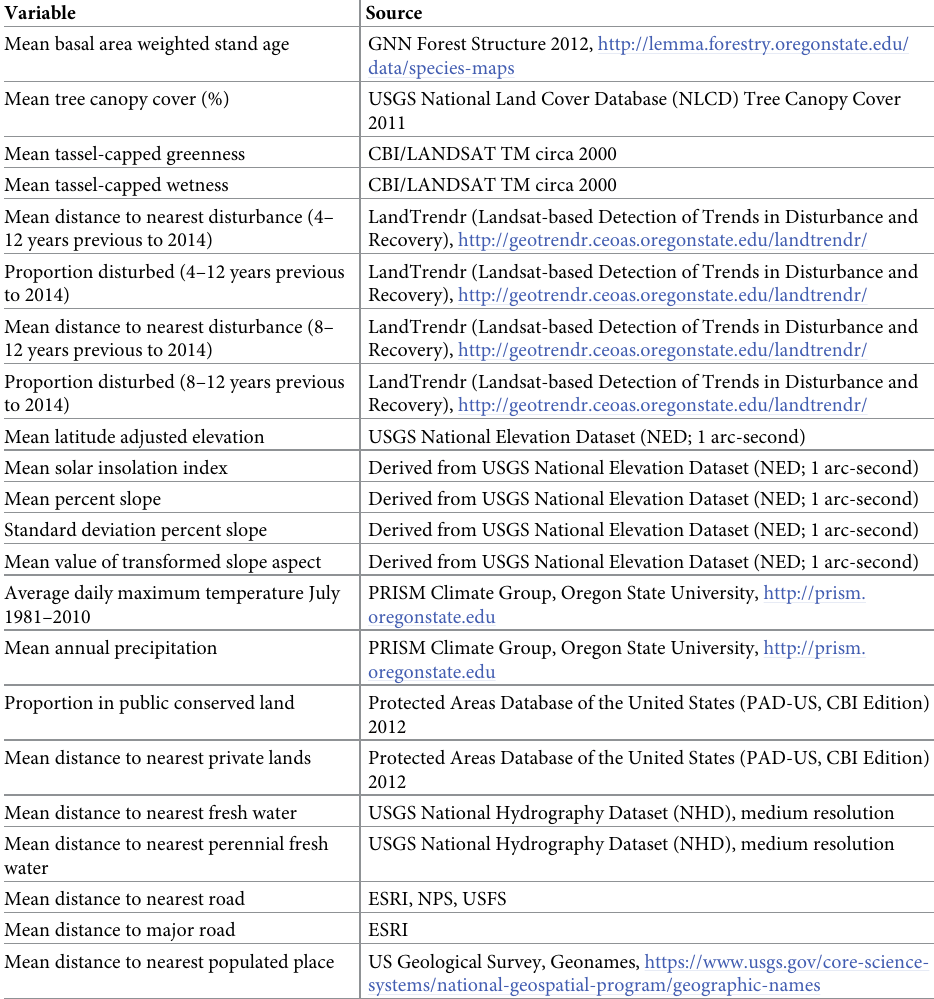
Table 1. Candidate environmental variables evaluated for use in the MaxEnt cannabis grow-site distribution model at 90m resolution.